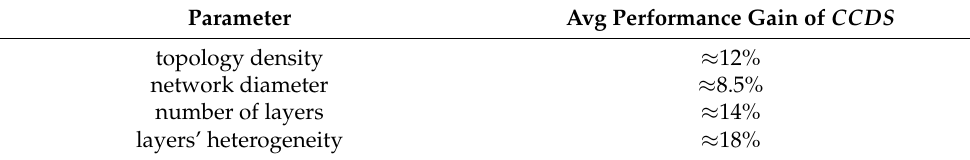
Table 3. Results’